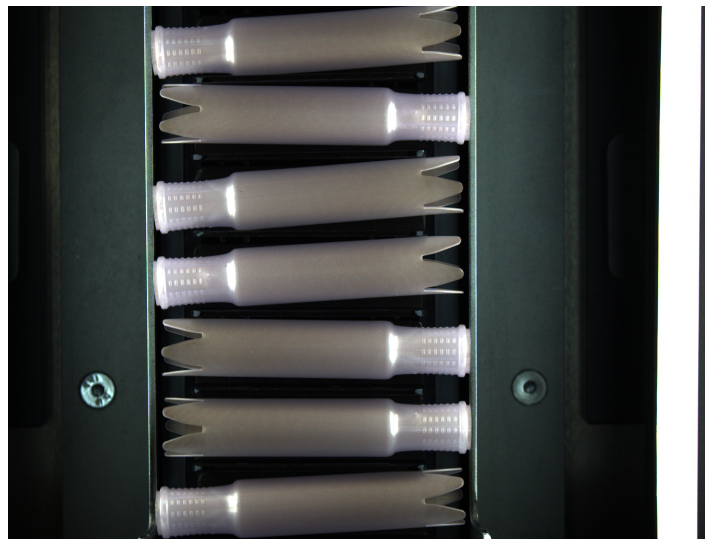
Figure 2. Products on the Rail photographed with a Vision